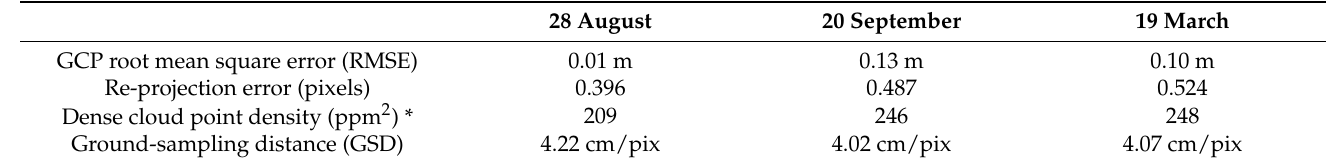
Table 2. UAV data pre-processing values produced by Agisoft Photoscan Pro.